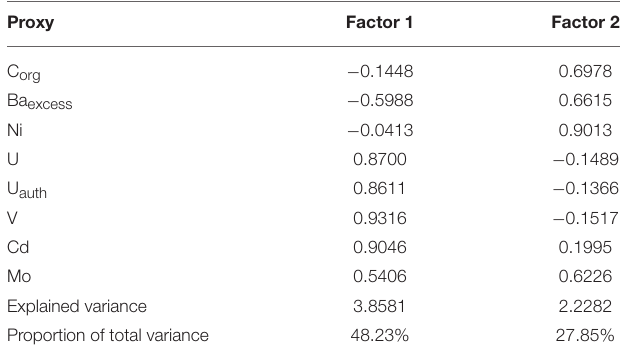
TABLE 4 | Factor loadings of the R-mode Factor Analysis with Varimax rotation performed on a combined dataset of cores C37A (Alfonso Basin) and C52A (La Paz Basin).